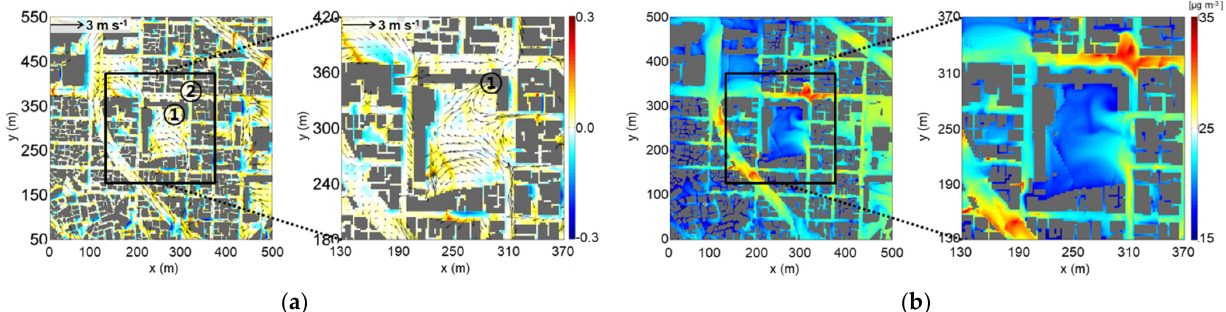
Figure 6. ( a ) Wind vectors and shading of the vertical velocity distribution, ( b ) PM 2.5 concentrations at 1 m above the ground for the east–southeasterly inflow in the CNTL case.